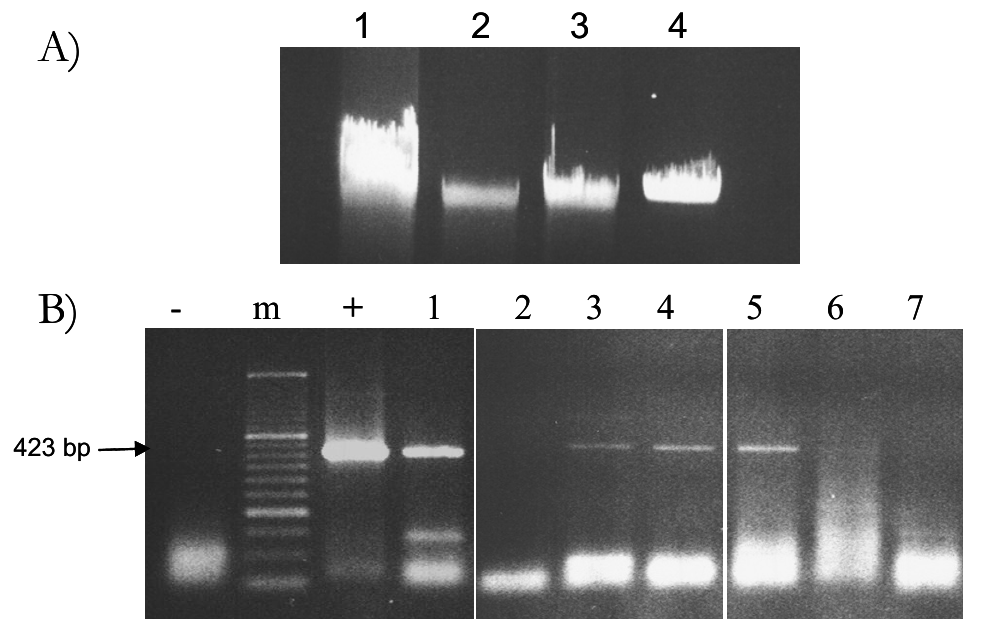
Figure 1. (A) Total DNA extracted from whole milk (lane 1), skimmed (lane 2) and fat (lane 3) milk fractions extracted by CTAB/phenol:chloroform protocol. Milk-derived DNA samples are compared to a known amount of standard high molecular weight phage λ DNA (lane 4). (B) . rbcL 423 bp long fragment, PCR amplified with the Lrub fw/rv primer combination from the whole, skimmed and fat milk DNA samples shown in panel A, used at the following amount: lane 1: 400 ng of total milk DNA; lane 2, 3, 4: 200 ng, 400 ng and 800 ng of DNA recovered from the skimmed fraction; lane 5, 6, 7: 200 ng, 400 ng and 800 ng of DNA recovered from the fat fraction; m: molecular marker; “-”: negative control (just buffer); “+”: plant DNA positive